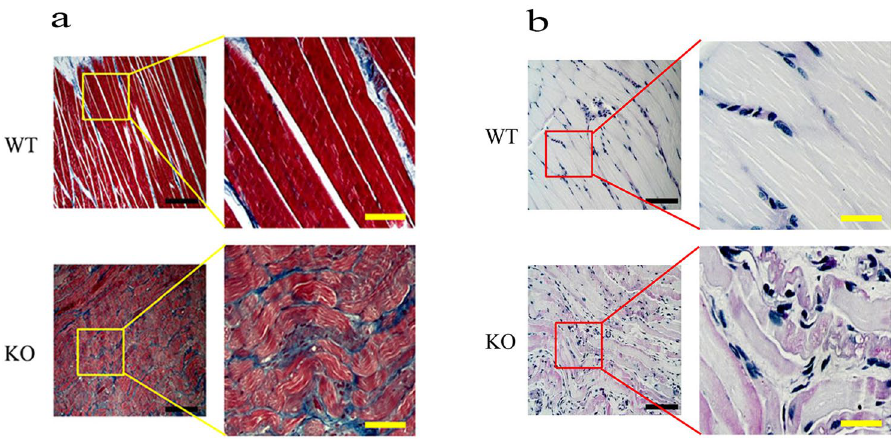
Figure 4. Histopathology of skeletal muscle from Lamp2 y/ − rats and wild-type rats (8 weeks). ( a ) Masson Trichrome staining; ( b ) PAS staining. The back bars correspond to 200 μ m, and the yellow bars correspond to 2 mm. WT, wild-type male rats; KO, Lamp2 y/ −